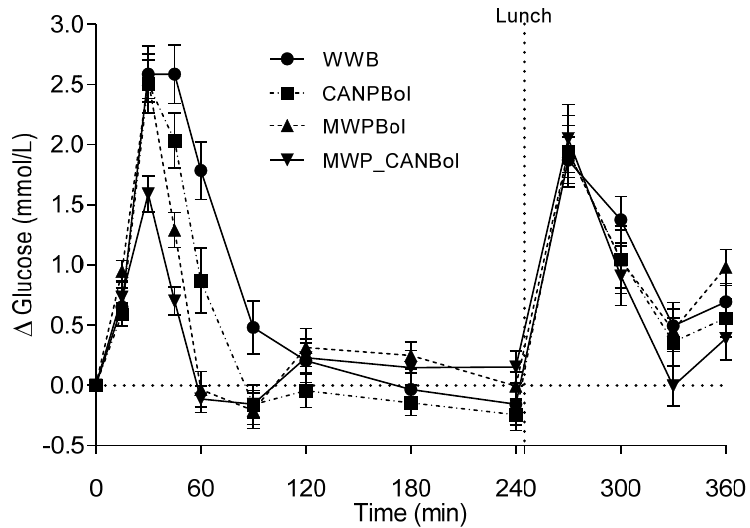
Figure 1. Mean (±SEM) changes in glucose response after the test meals and reference meal and the subsequent standardized lunch (Study 2). Table 3. Glucose and insulin responses 1 , together with a measure of insulin sensitivity after the test meals and the reference meal (Study 2).